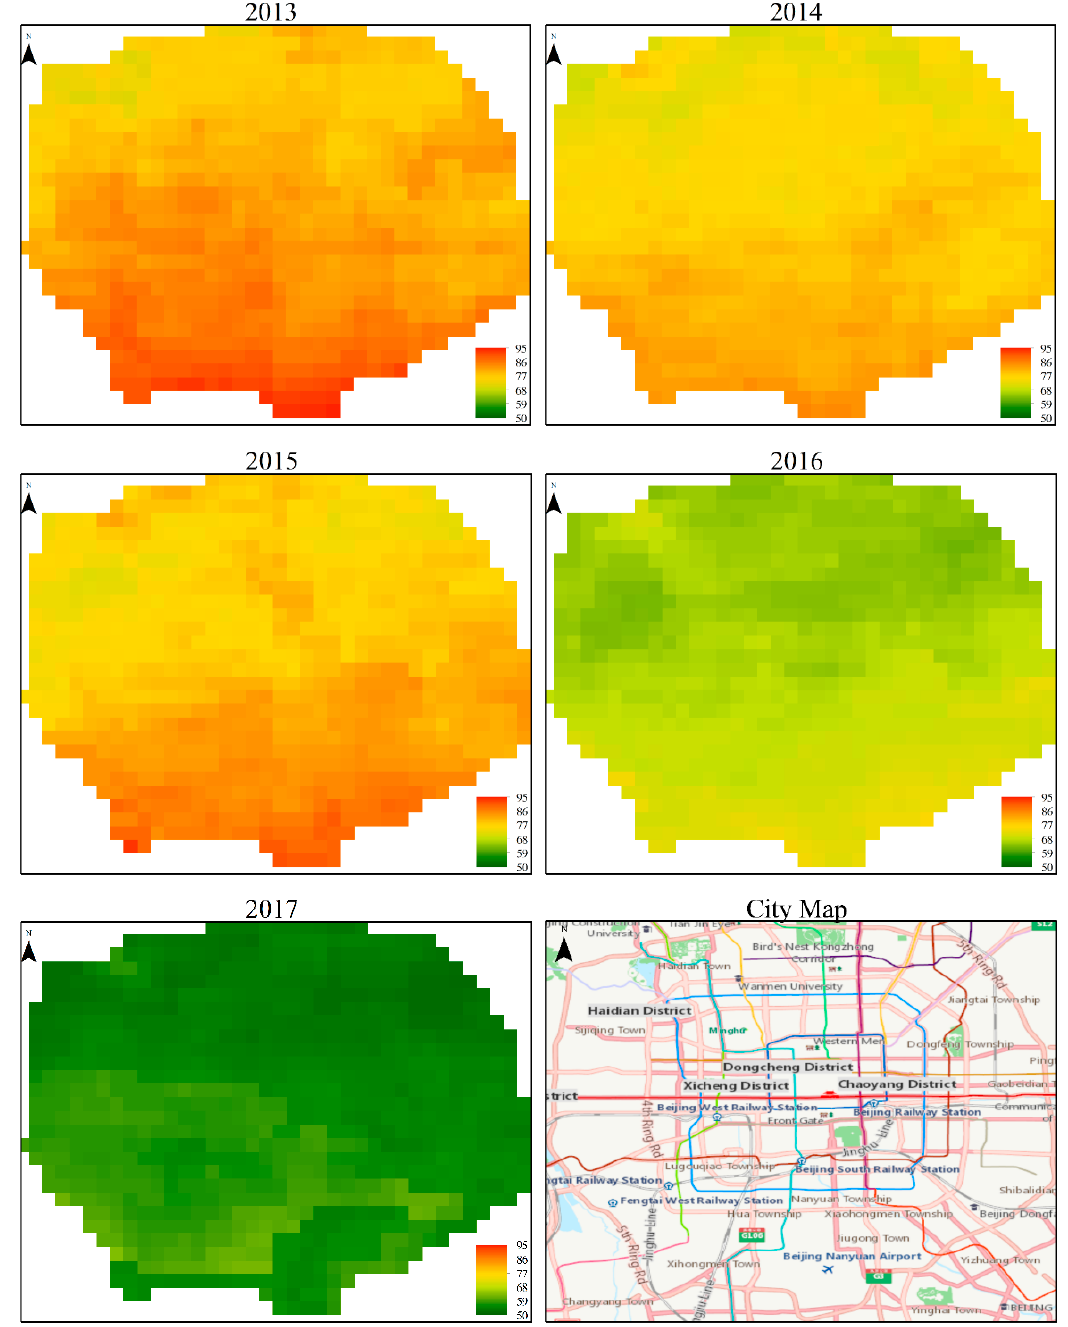
Figure 9. Mean PM 2.5 concentration ( µ g/m 3 ) calculated from daily PM 2.5 estimations for each year and a city map over the downtown area of Beijing.